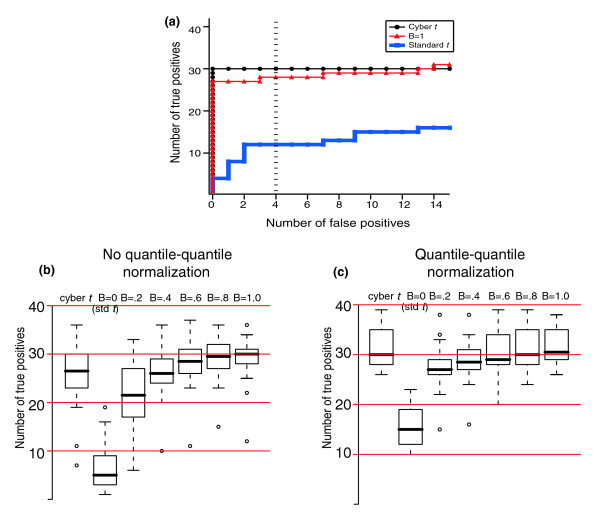
The performance of test statistics in ranking the Latin Square data. (a) ROC curves for Latin Square experiments 8 versus 9. (b,c) The number of true positives captured for all 14 2× Latin Square experiments at a threshold that also captured four false positives (dashed line in panel a) in the absence (panel b) and presence (panel c) of background correction and quantile-quantile normalization. B refers to the 'shrinkage factor' in Equation 3 (see text). For this and the following figures in the report, data were summarized with RMA before application of the test statistic. RMA, Robust Multichip Average; ROC, receiver operating characteristic.